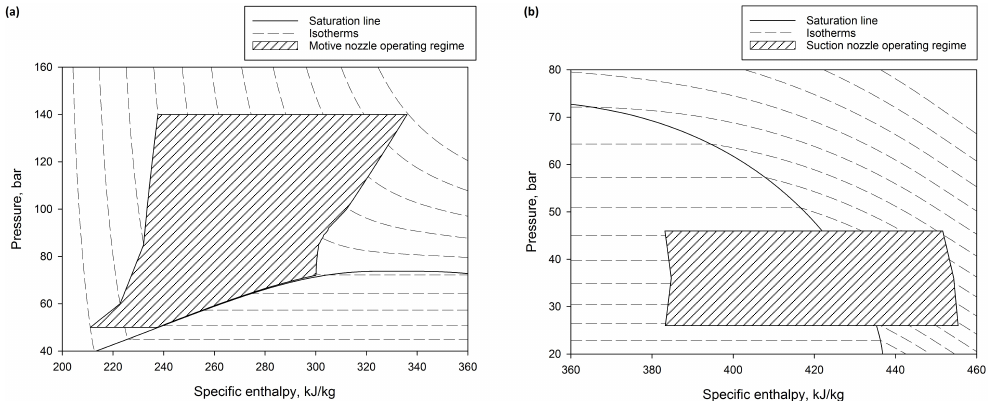
Figure 2. The operational envelope of the hybrid reduced-order model (ROM): ( a ) the motive nozzle conditions; ( b ) the suction nozzle